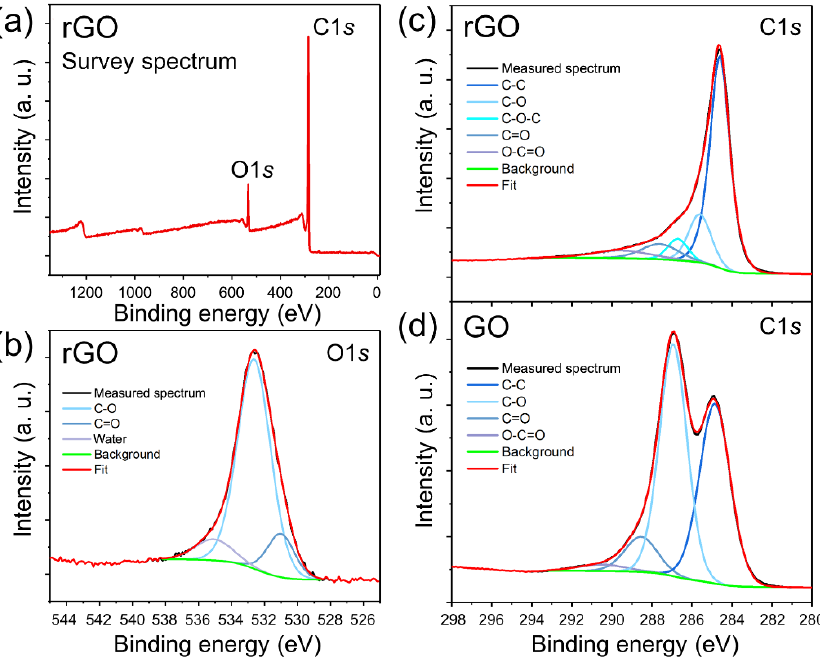
Figure 2. X-ray photoelectron spectroscopy (XPS) characterization of GO and rGO. ( a ) XPS survey spectrum of rGO. (b) XPS O 1s spectrum of rGO. (c) XPS C 1s spectrum of rGO. (d) XPS C 1s spectrum of GO.